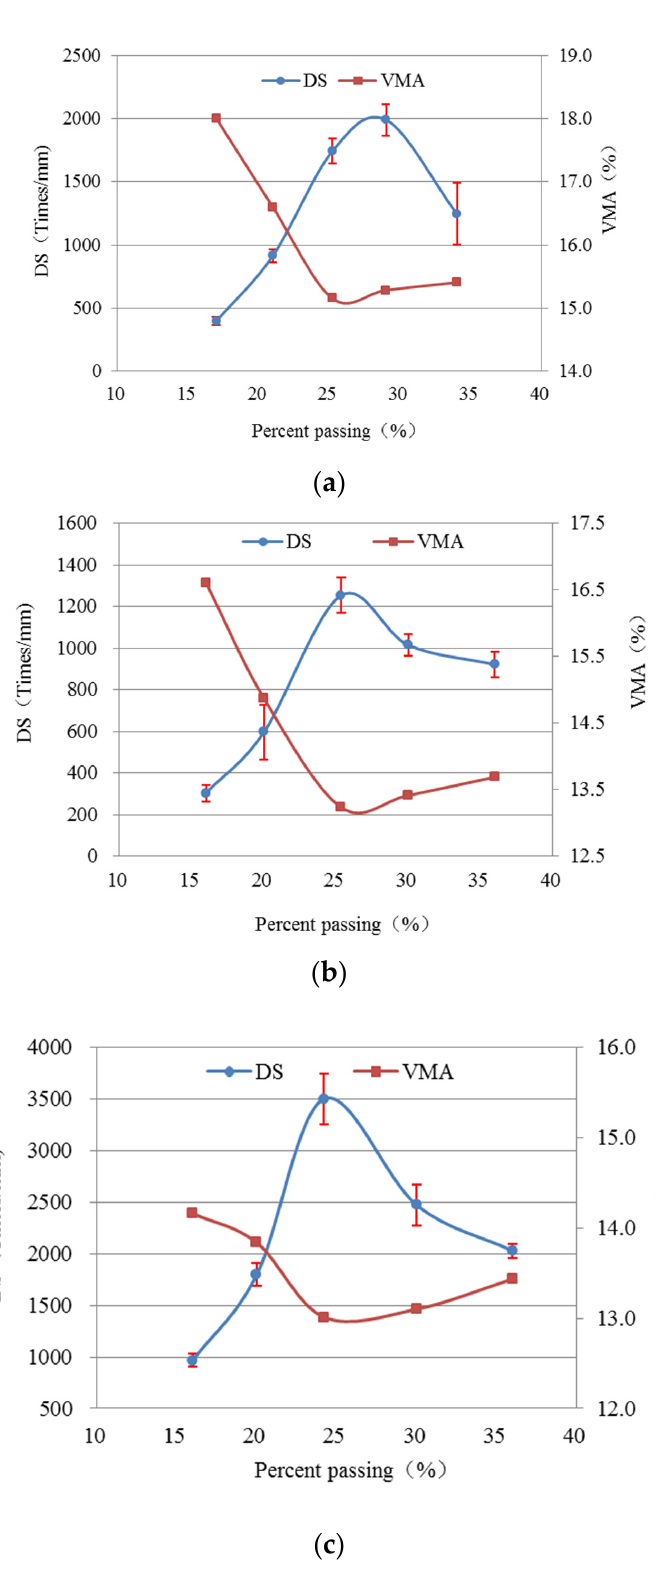
Figure 9. The values of DS and VMA of various AC mixtures versus PP. ( a ) AC-13; ( b ) AC-20; ( c )